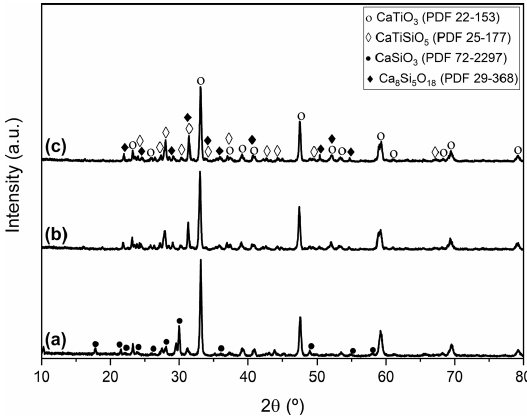
Figure 3. XRD patterns of glass-ceramics obtained from Ca Glass treated at 960 ºC during (a) 2 hs, (b) 4 hs and (c) 6 hs. Assignments: